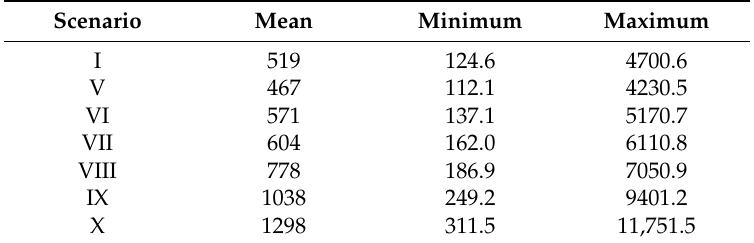
Table 3. Characteristics for the flow rates (cfs) at the Sumatra gage for additional scenarios.